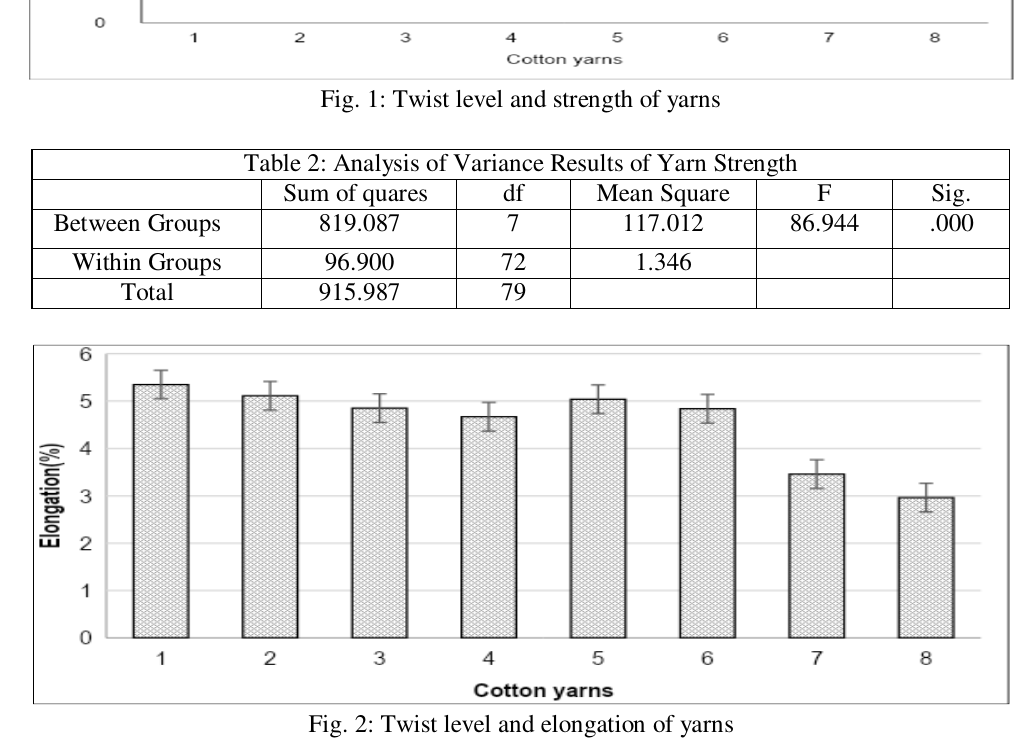
Fig. 2: Twist level and elongation of